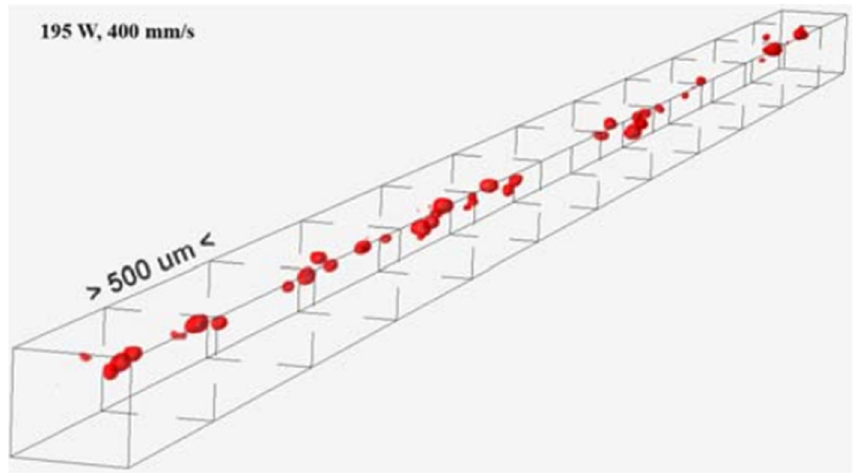
Figure 7. 3D view of keyhole pores [6].